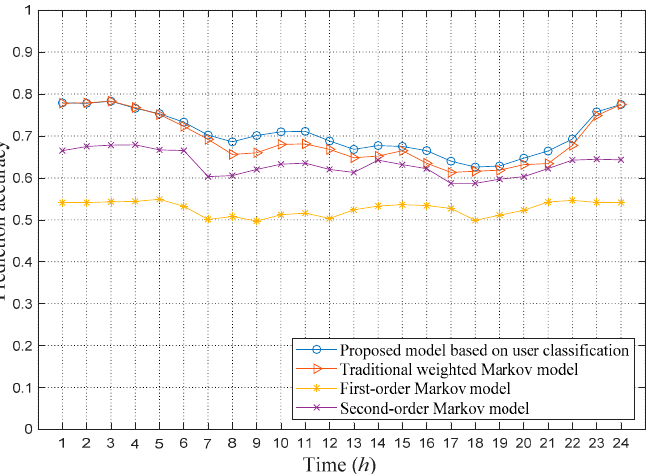
Figure 5. Comparison of prediction accuracy of different Markov models.